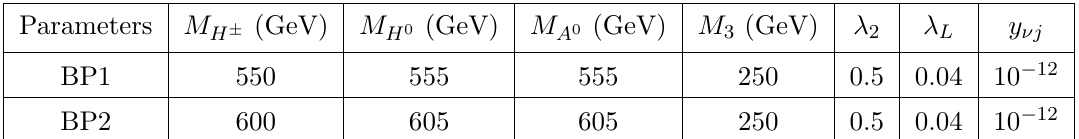
Table 3 . Benchmark points for studying the discovery prospects of stable charged tracks of H (cid:6) for IDM at 14 TeV run of LHC.